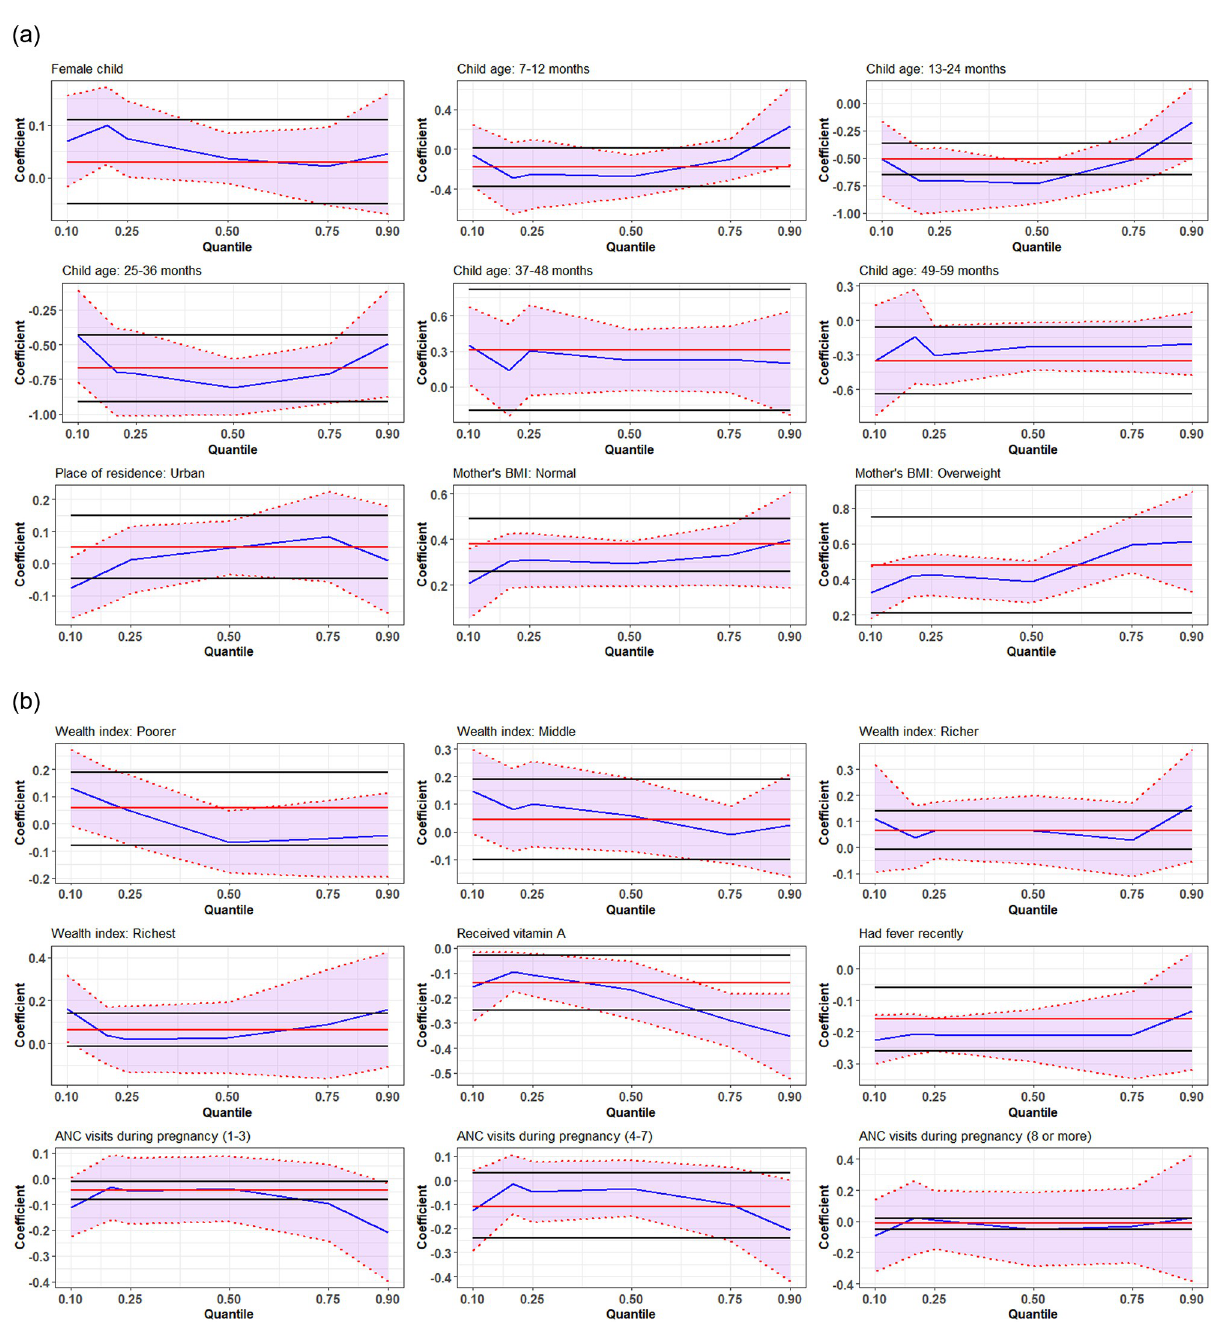
Fig 2. Plot of covariate effects on quantiles from multivariable simultaneous quantile regression (blue line) and their associated 95% confidence interval (purple shaded regions). The solid red lines are the ordinary least square regression lines with their 95% confidence intervals (black lines).